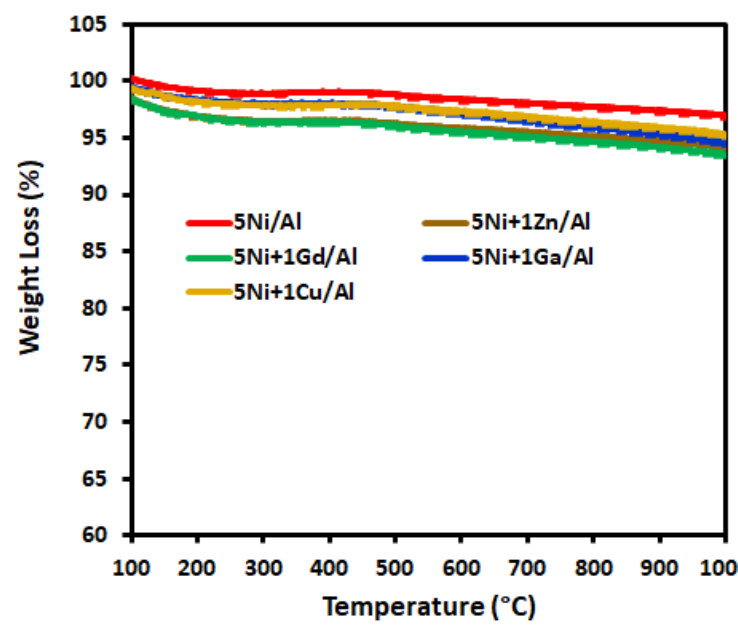
Figure 5. Thermogravimetric analysis (TGA) curves of the spent catalysts.